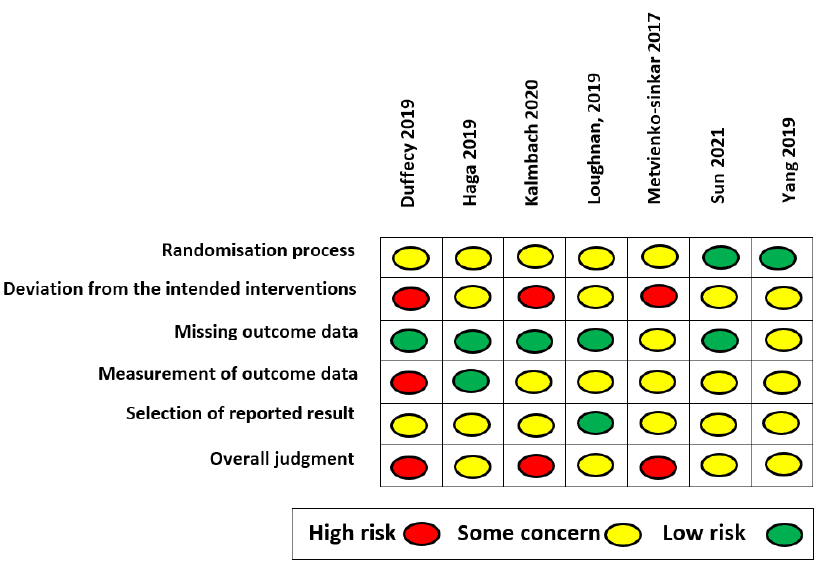
Figure 8. Risk of bias in individual